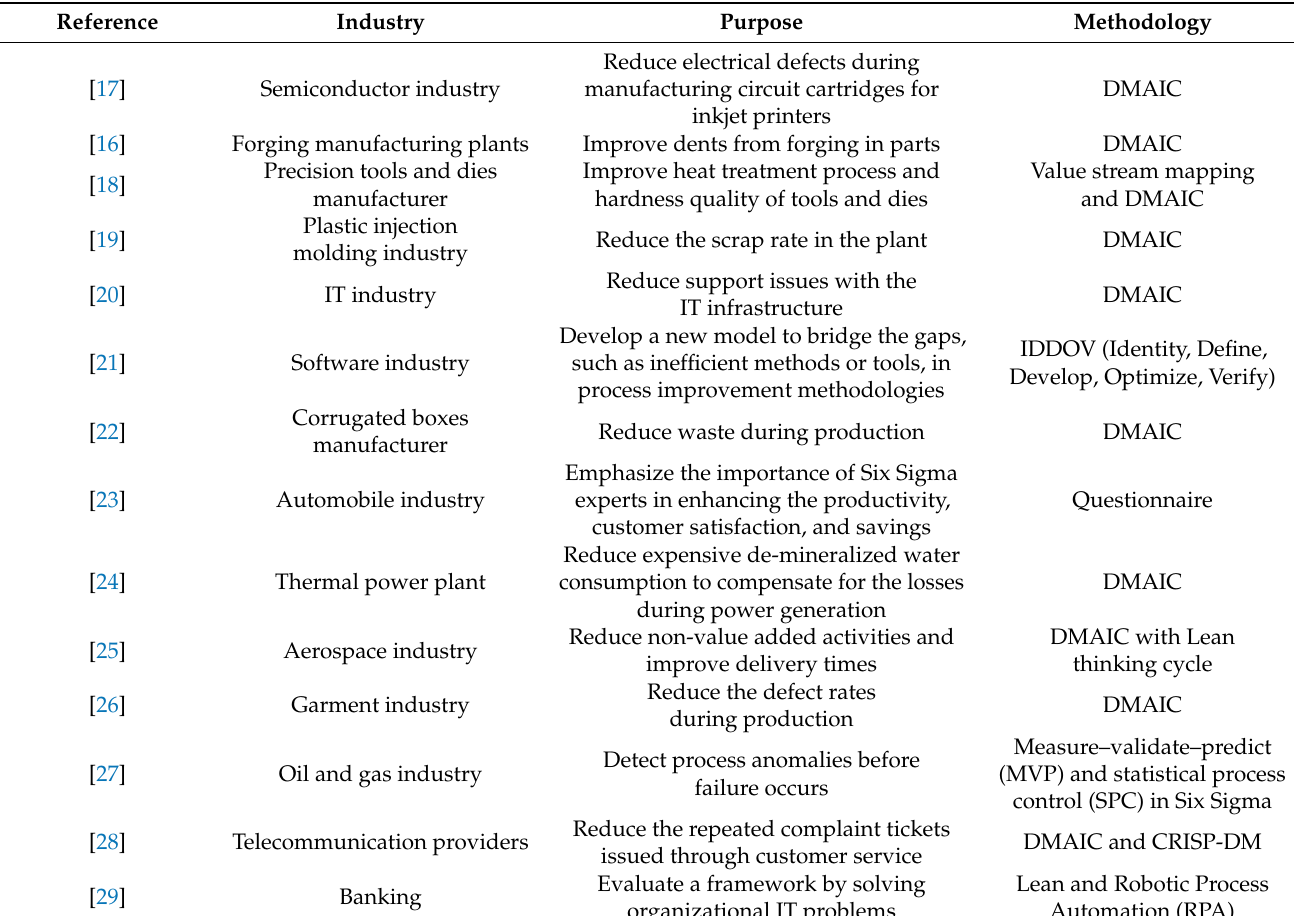
Table 1. Summary of literature review in application of Lean Six Sigma and its tools in